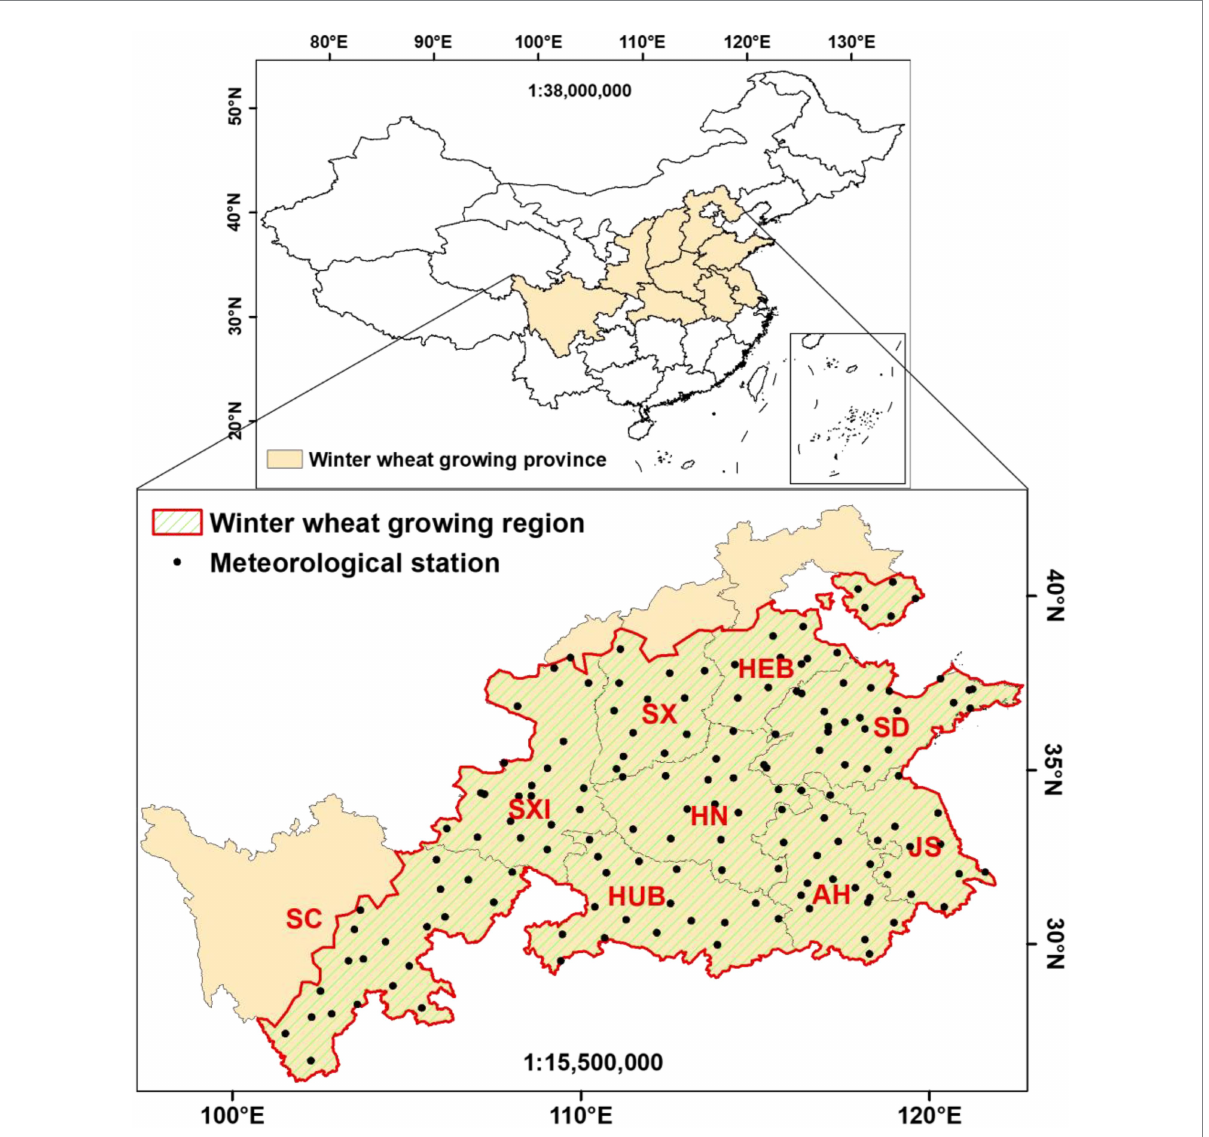
FIGURE 1 The study area (HEB, Hebei; SD, Shandong; SX, Shanxi; SXI, Shaanxi; HN, Henan; SC, Sichuan; HUB, Hubei; AH, Anhui; JS,